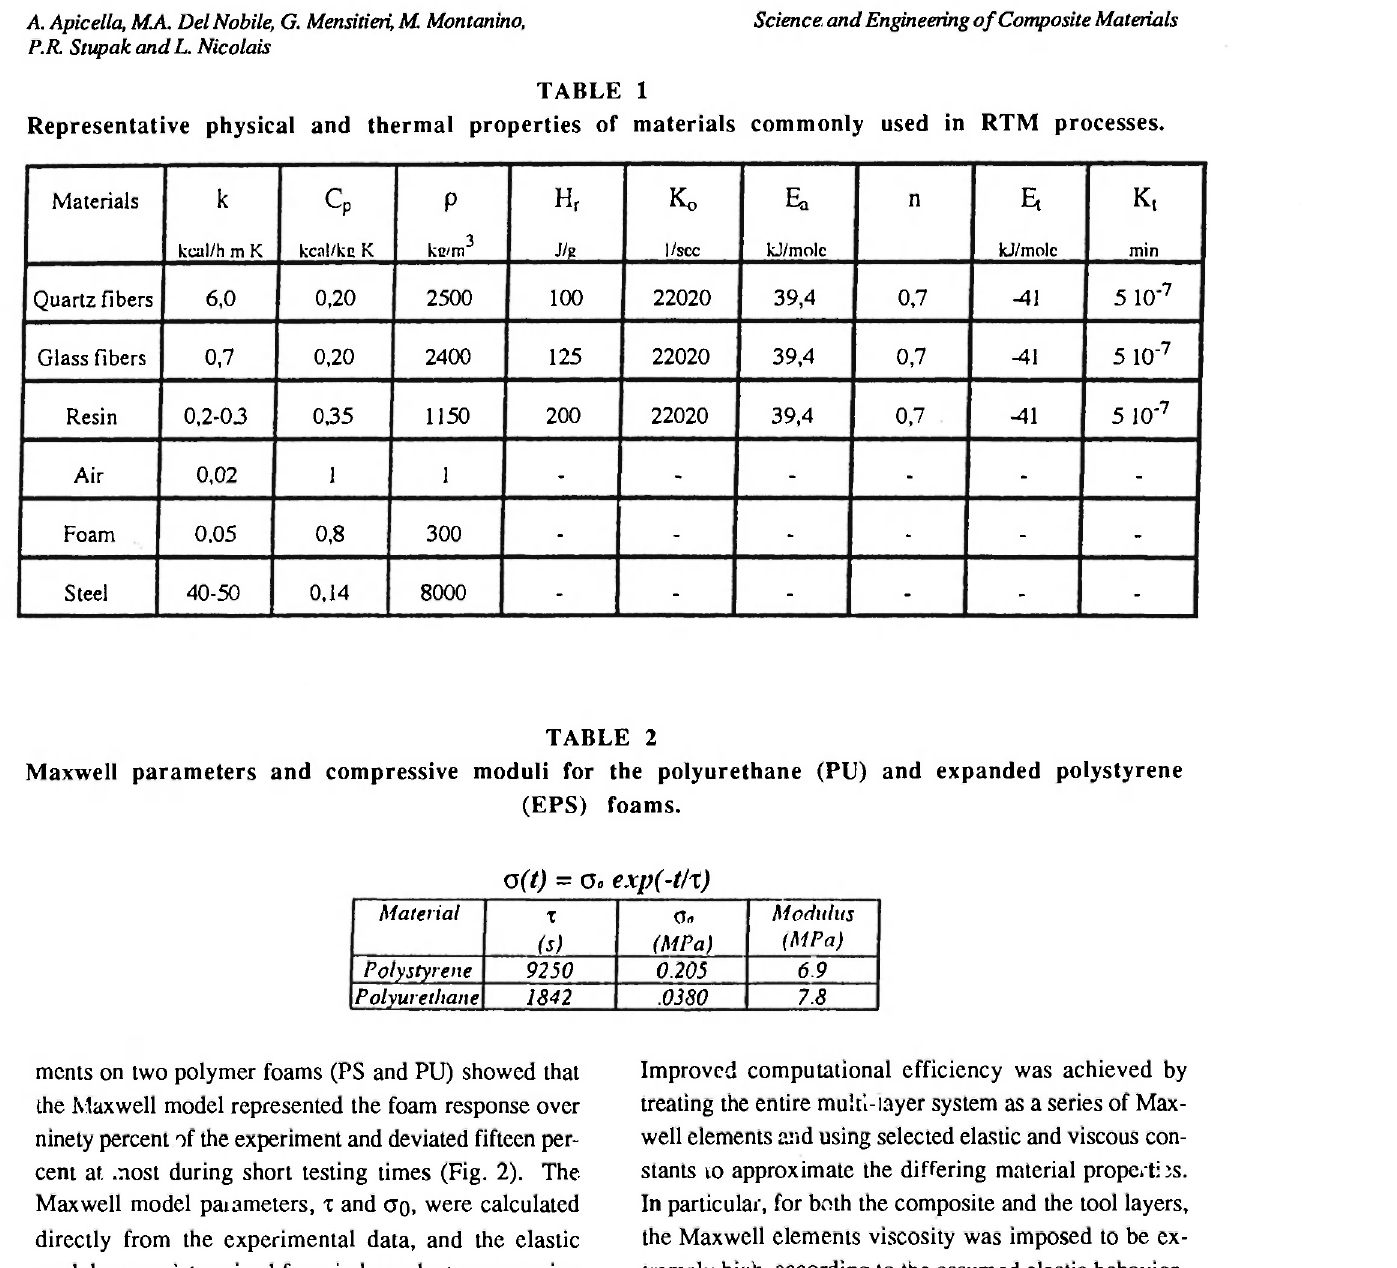
ments on two polymer foams (PS and PU) showed that the Maxwell model represented the foam response over ninety percent of the experiment and deviated fifteen per- cent at. .Tiost during short testing times (Fig. 2). The Maxwell model parameters, τ and σο, were calculated directly from the experimental data, and the elastic modulus was determined from independent compression tests conducted at the same strain rate (Table 2). Development of the temperature profile through the foam layer yielded more extensive and rapid stress relaxation in the sub-layers where the temperature was greatest (Fig. 3). This was represented in the numerical model as a series of Maxwell elements with different relaxation times corresponding to cach sub-layer tem- perature. The temperature dependence of the